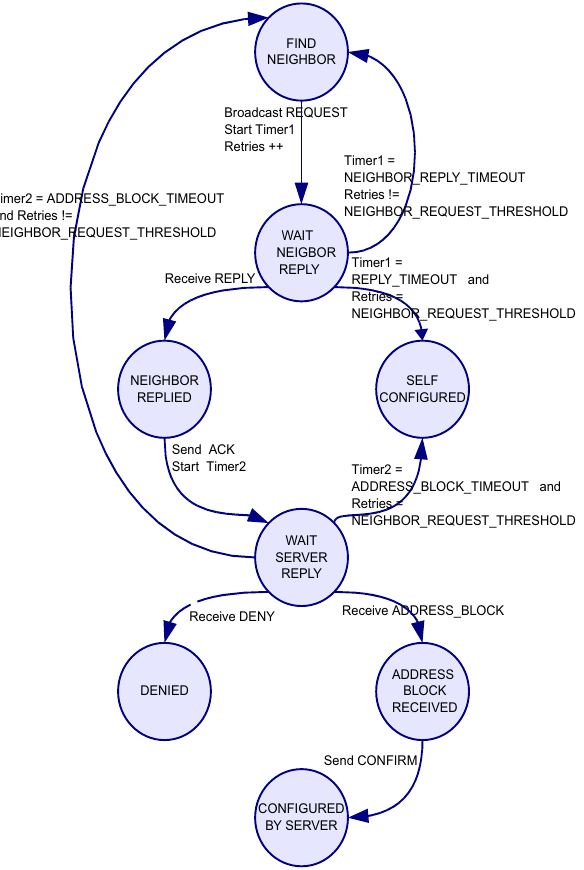
Figure 4. State diagram of a client node during the address allocation process of IPAA